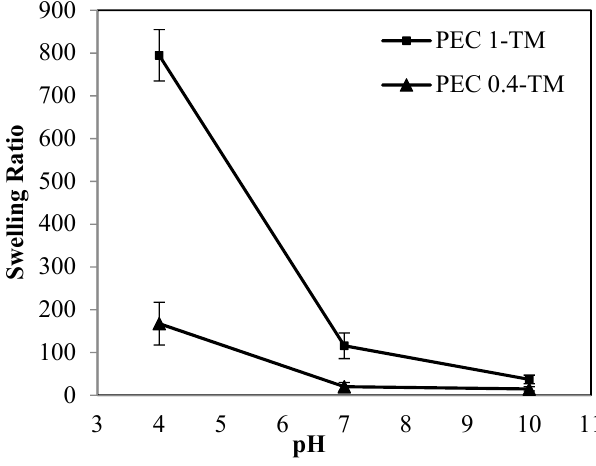
Figure 5. pH Sensitivity of TM-PEC films.